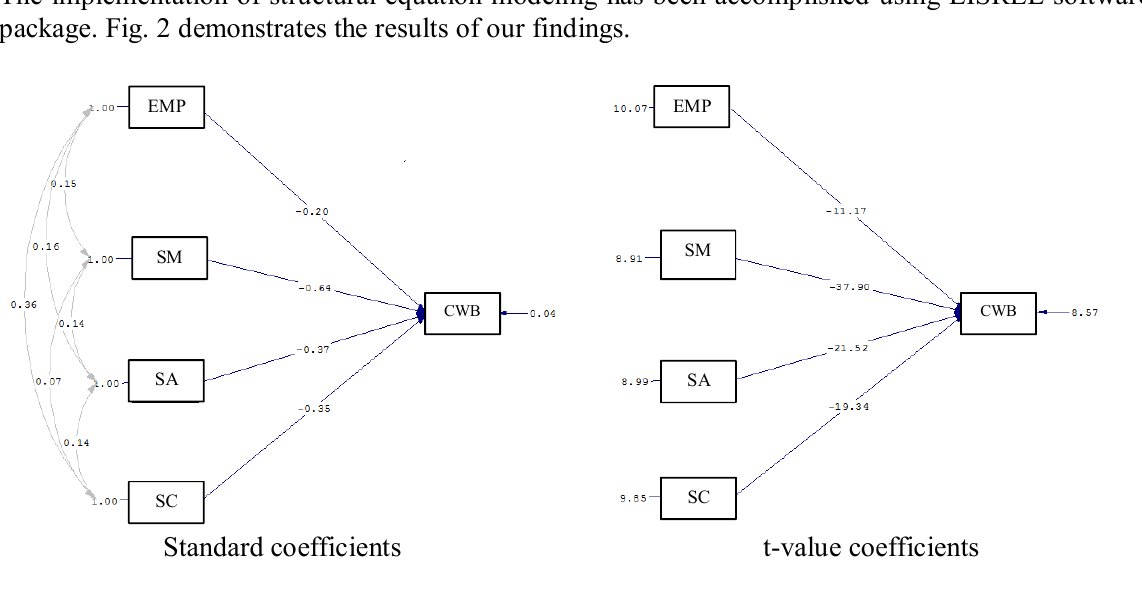
Fig. 2. The results of the implementation of structural equation modeling